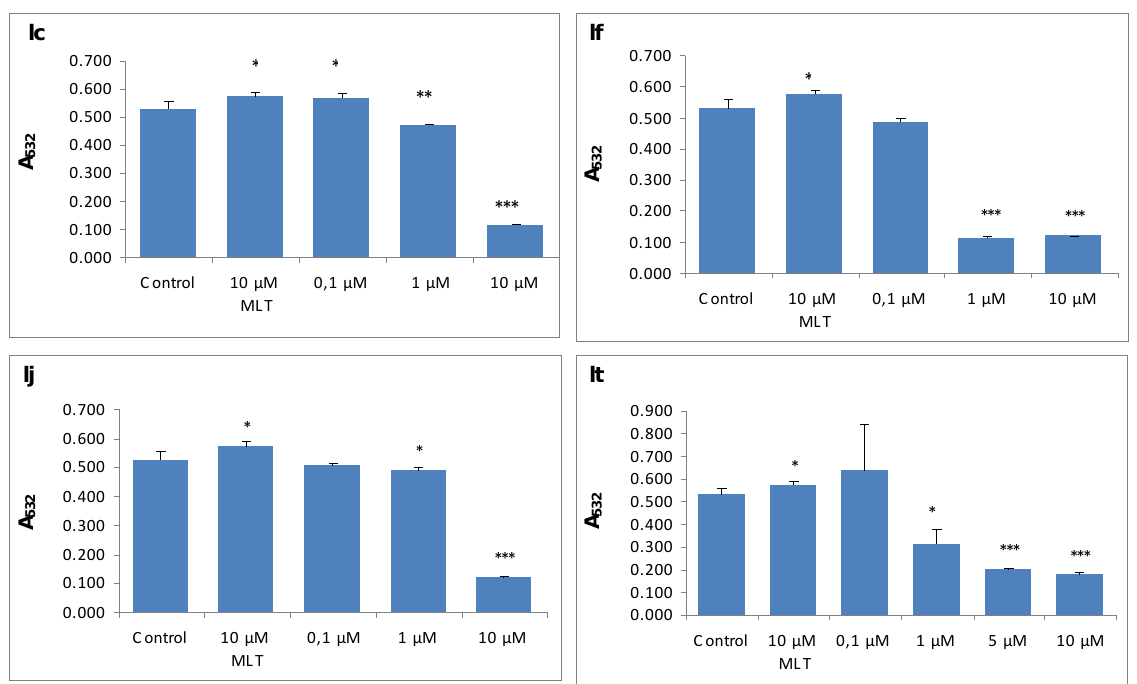
Figure 4. Effects of various concentrations of 1c , 1f , 1j and 1t on H Values are mean ±SD of three individual experiments. * p < 0.05, ** p < 0.01, *** p < 0.005 significantly different from